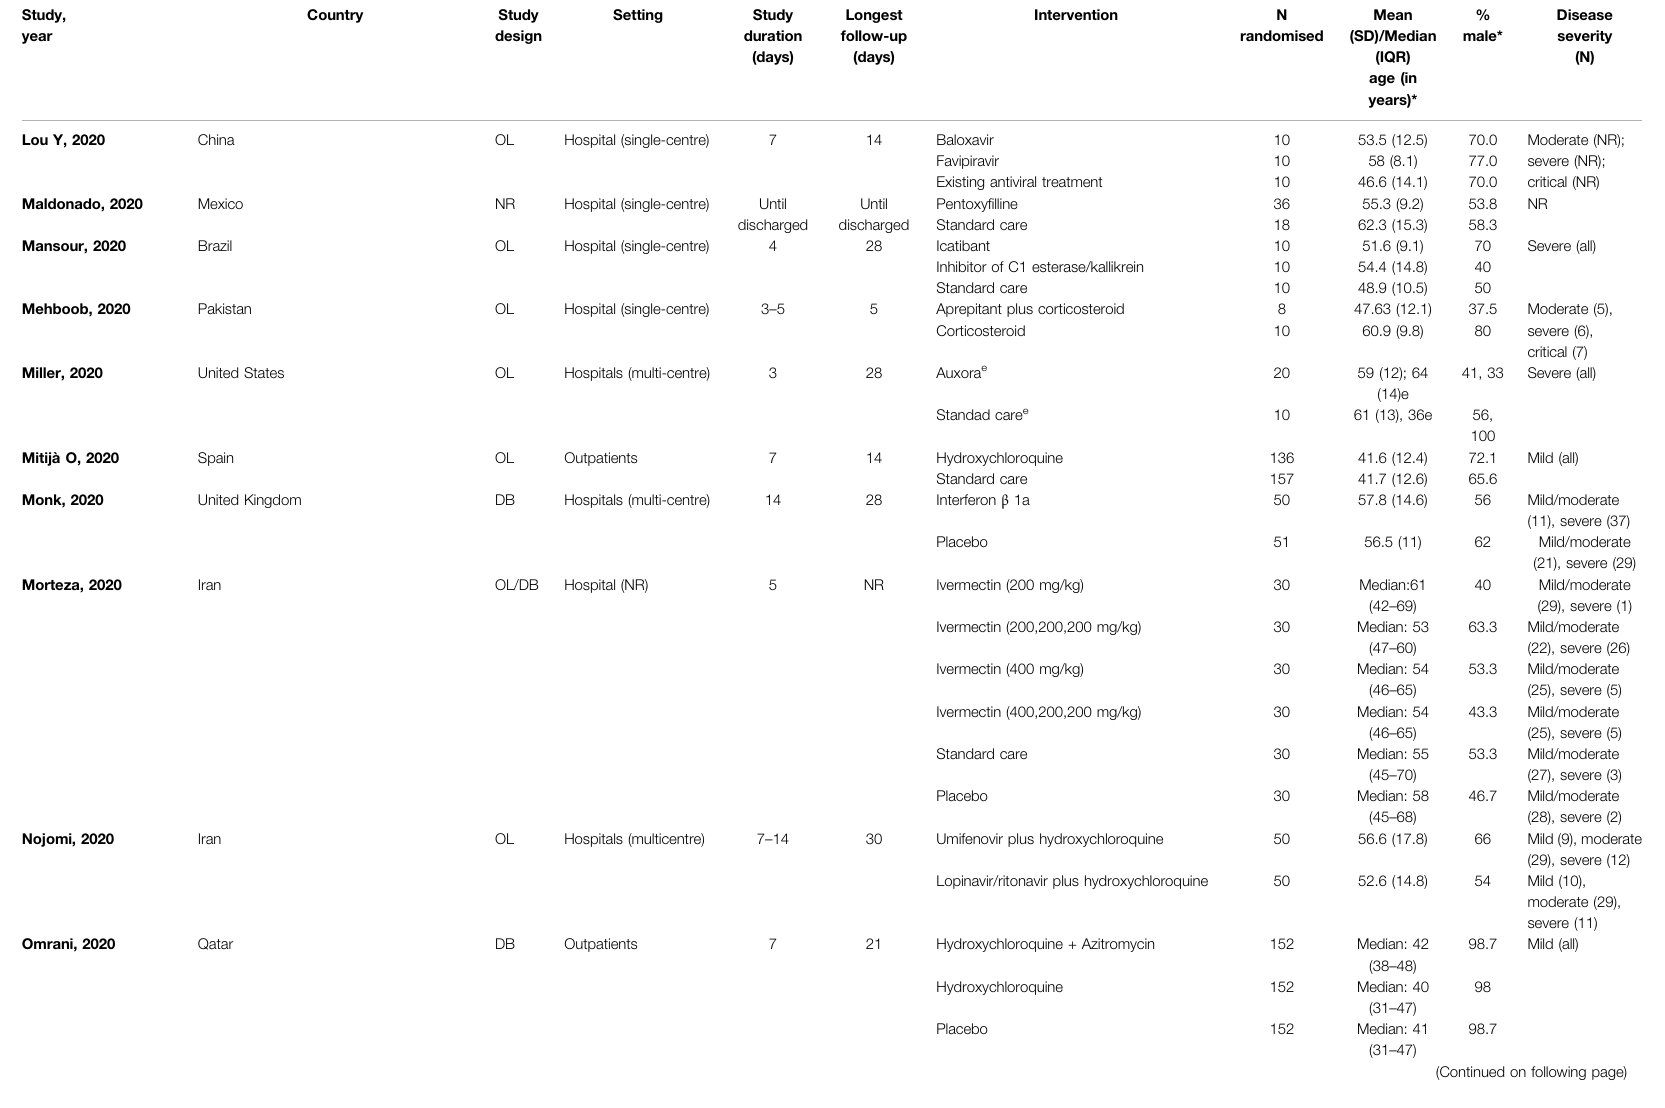
TABLE 1 | ( Continued ) Characteristics of included randomized controlled